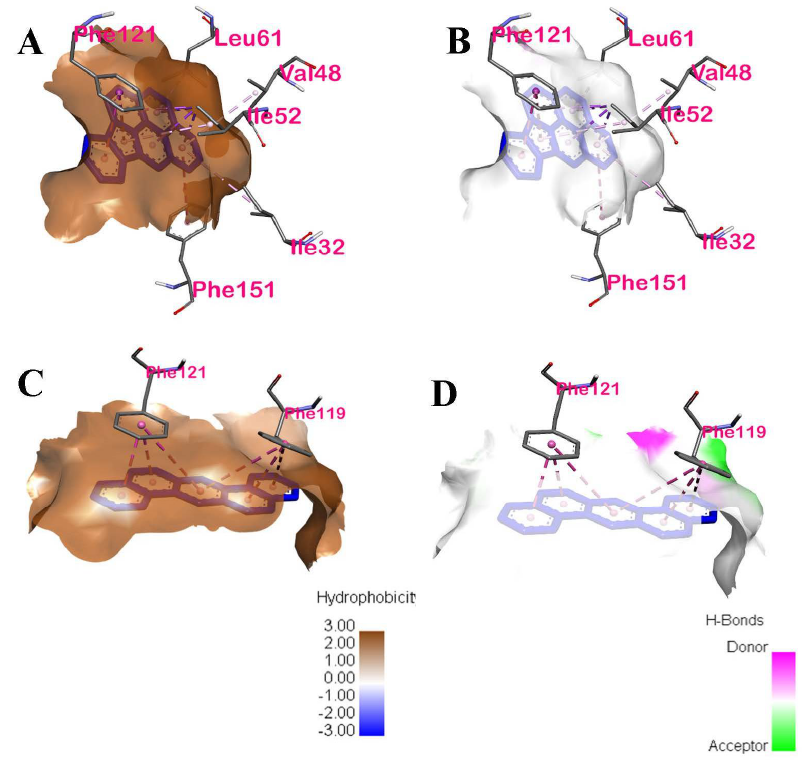
Figure 9. Intermolecular forces of attractions between DahA − TLR4 and IP − TLR4: ( A ) hydrophobic interaction of TLR4 amino acids with Indeno(1,2,3-cd)pyrene; ( B ) H − bonding of TLR4 amino acids with Indeno(1,2,3-cd)pyrene; ( C ) hydrophobic interaction of TLR4 amino acids with Dibenz(a,h)anthracene; ( D ) H-bonding of TLR4 with Dibenz(a,h)anthracene. Additionally, the distance of interaction between the ligands IP and DahA and the amino acids of TLR4 are shown in Table 4. Chain D Ile52 of TLR4 interacts hydrophobically with IP by pi-sigma at three (3) locations at distances of 3.3891 Å, 3.89425 Å, and 3.44148 Å, and by pi-alkyl at one (1) location of the ligand at a distance of 4.62034 Å; chain D Phe121 of TLR4 interacts hydrophobically with IP by pi-pi stacking at two (2) locations at distances of 4.14965 Å, and 4.64929 Å; chain D Phe151 of TLR4 interacts hydrophobi- cally with IP by pi-pi T-shaped at one (1) location by a distance of 5.84498 Å; chain D Leu61 of TLR4 interacts hydrophobically with IP by pi-alkyl at one (1) location by a dis- tance of 5.18222 Å; chain D Ile32 interacts hydrophobically with IP by pi-alkyl at one (1) location by a distance of 5.47123 Å; and chain D Val48 interacts hydrophobically with IP by pi-alkyl at one (1) location by a distance of 5.16885 Å. On the other hand, chain D Phe119 of TLR4 interacts hydrophobically with DahA by pi-pi stacking at three (3) loca- tions at distances of 5.52106 Å, 4.47965 Å, and 5.42439 Å, and chain D Phe121 also interacts hydrophobically with DahA by pi-pi stacking at three (3) locations at distances of 5.11694 Å, 3.86586 Å, and 3.74824 Å.